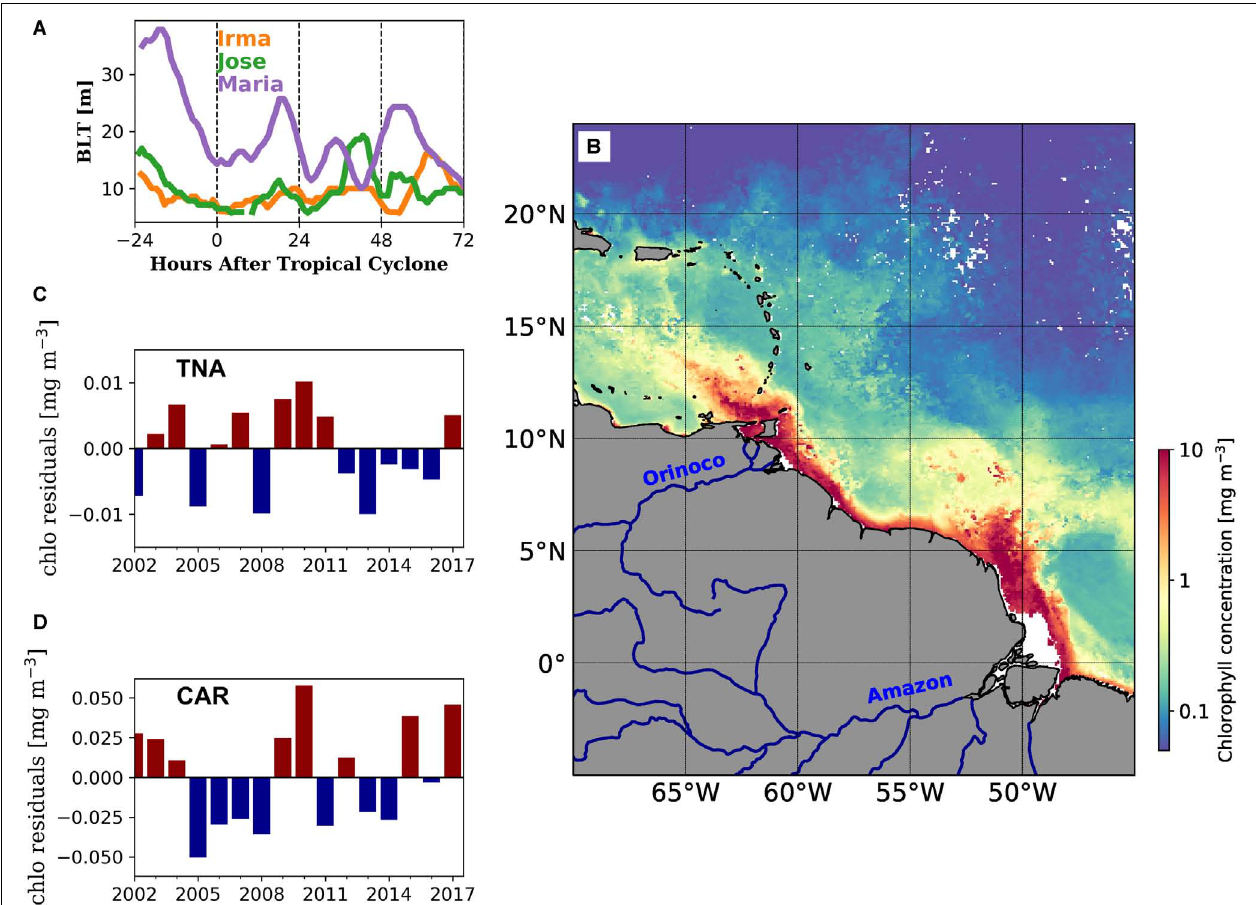
FIGURE 8 | (A) Barrier layer thickness (BLT) calculated using underwater glider observations collected in areas off Puerto Rico under major 2017 TCs. (B) Average surface chlorophyll concentration for August 2017 derived from MODIS-Aqua data. Major rivers contributing to elevated chlorophyll concentrations are indicated. (C) Chlorophyll anomalies during hurricane season in the Tropical North Atlantic (TNA) Ocean for areas off Puerto Rico. (D) Same as (C) , but for areas in the Caribbean Sea (CAR) off Puerto